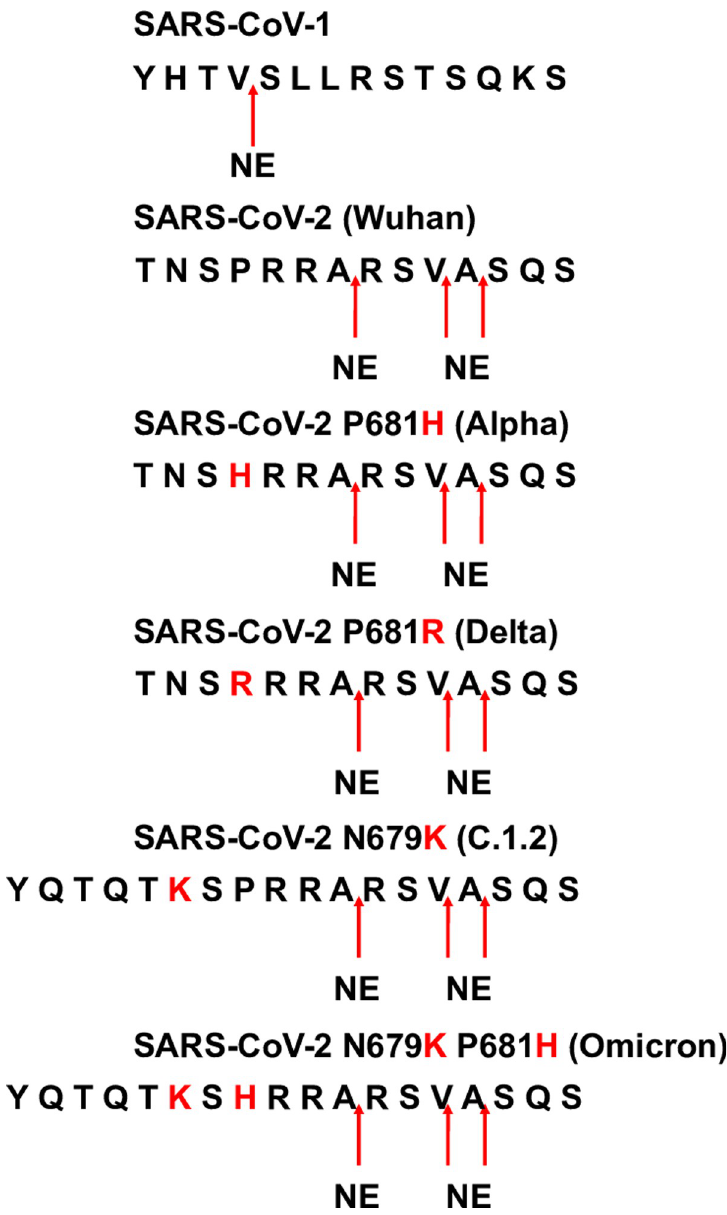
Fig 2. NE cleavage site prediction covering the polybasic sequence of the activation loop of the S protein. Potential cleavage sites of NE at the proteolytically sensitive activation loop of SARS-CoV-1, SARS-CoV-2 (Wuhan), SARS-CoV-2 P681H (Alpha), SARS-CoV-2 P681R (Delta), SARS-CoV-2 N679K (C.1.2), and SARS-CoV-2 N679K P681R (Omicron) peptides were mapped using “ExPASy peptide cutter”. Red arrows indicate cleavage sites. NE digested SARS-CoV-1 between VS and were less prominent between TS (Fig 663 664 669 670 3B, right panel; S1–S3 Figs). NE catalyzed the hydrolysis of all SARS-CoV-2 variants at VA and AS . PR3 cleaved the peptides between VA (S4 and S5 Figs). 687 688 688 689 687 688 In an additional experiment, we tested whether the digestion pattern might change when